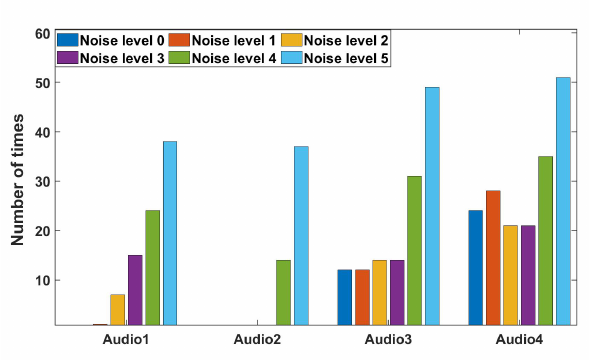
Figure 6. Number of times the user experiences noise that affects audio quality.